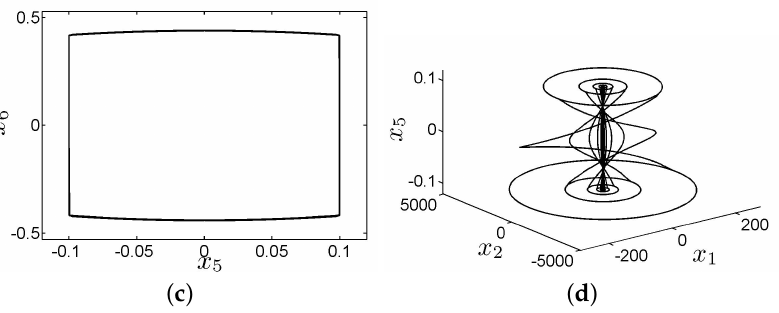
Figure 9. System response in three directions ( L = 520m). ( a ) The axial phase diagram. ( b ) The torsional phase diagram. ( c ) The lateral phase diagram. ( d ) Phase diagram in three directions.